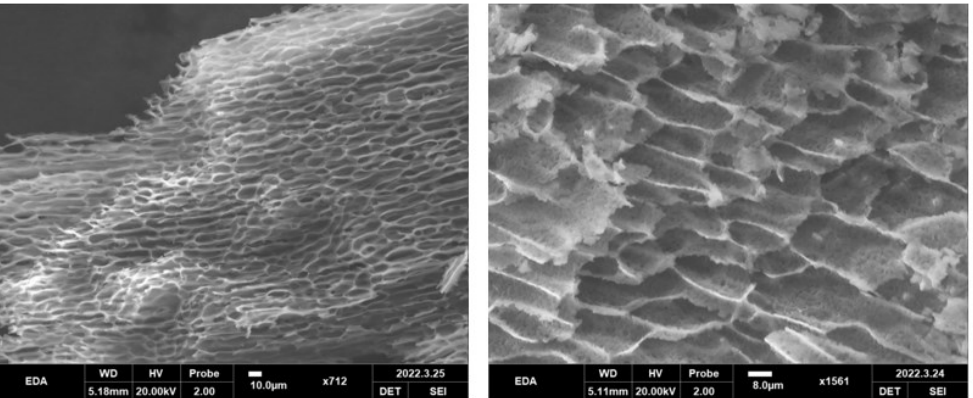
Figure 5. Micromorphology of EDA TSGs under SEM. An interwoven honeycomb structure with the pore diameter of about 10 μm was showed inside the gel.